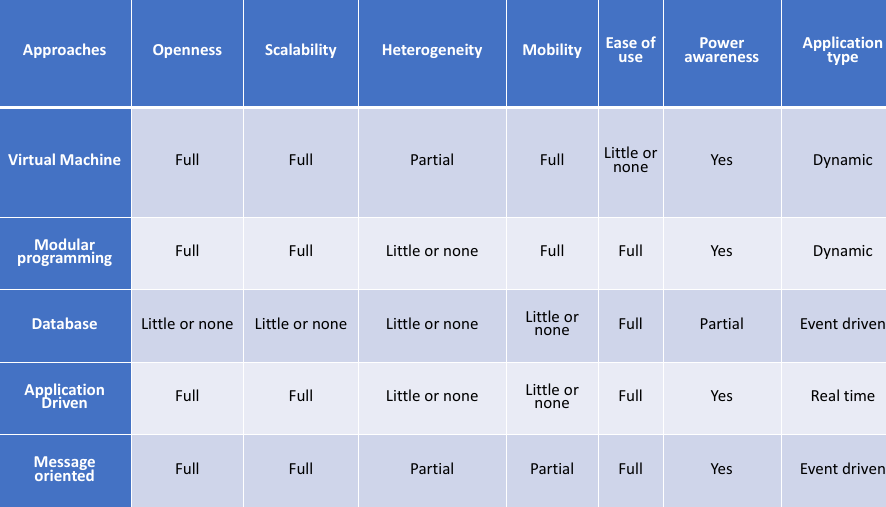
Figure 11. Middleware paradigms for